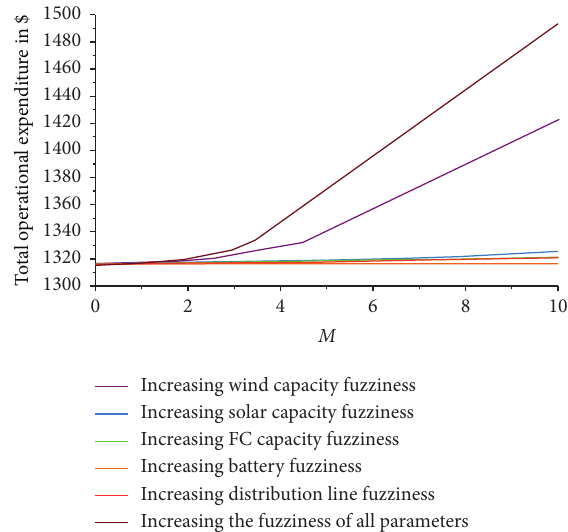
Figure 9: Impact of fuzzy parameter variations over the total operating